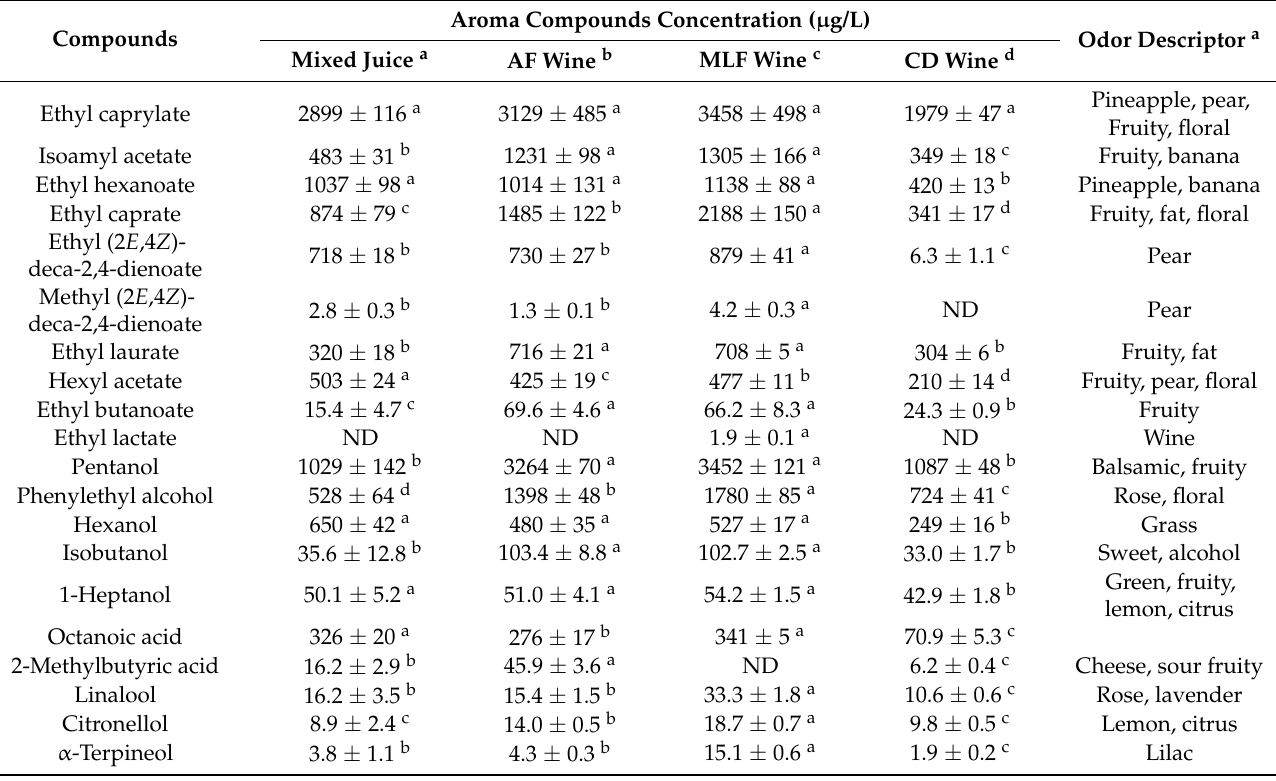
Table 4. Main aromatic compounds in pear–kiwifruit juice and corresponding wines with and without deacidification